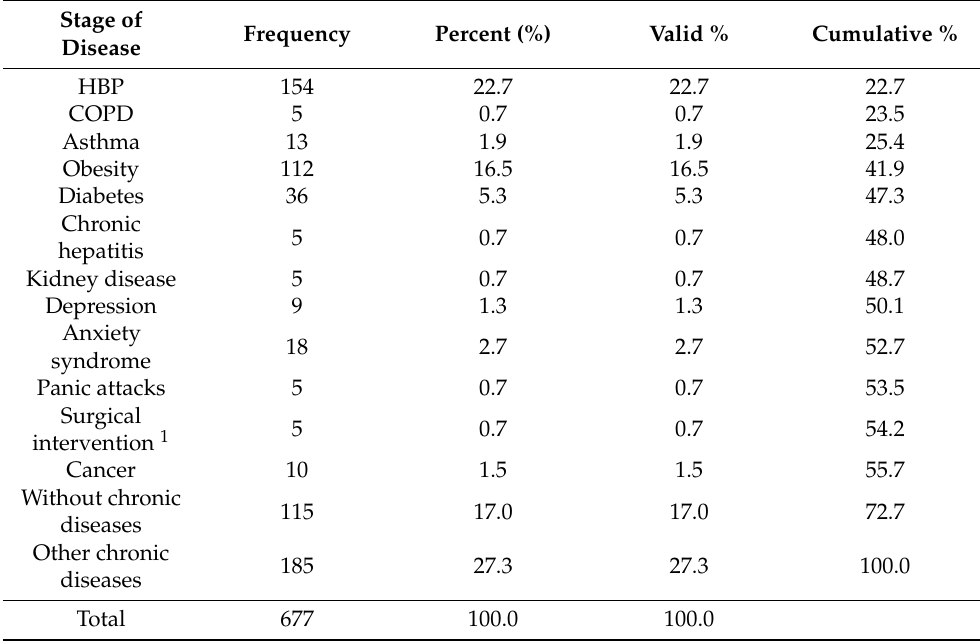
Table 2. Distribution of the chronic disease type of the subjects enrolled in the